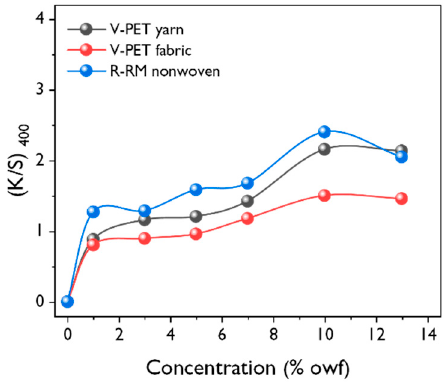
Figure 5. Effect of the dye concentration on the K/S value measured at 400 nm (dyeing temperature = 130 °C ; dyeing time = 60 min; liquor ratio = 1:50).